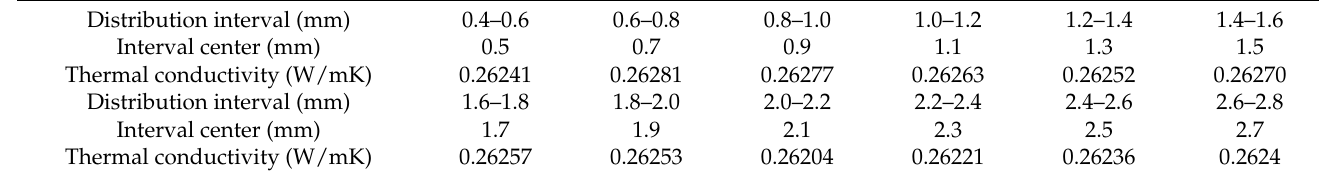
Table 7. Effect of pore diameter distribution on thermal conductivity.